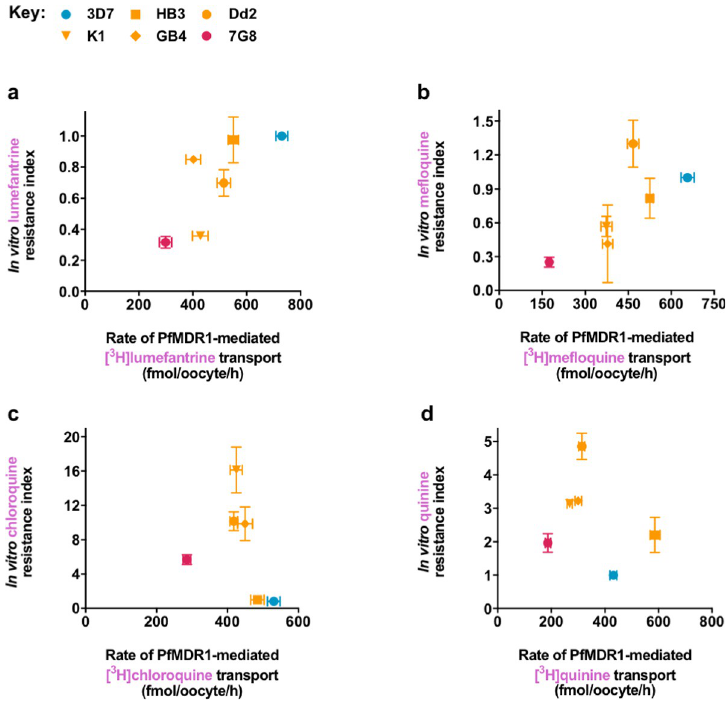
Fig 5. Correlations between rates of drug transport via PfMDR1 in Xenopus oocytes and in vitro parasite drug resistance indices. The rates of PfMDR1-mediated transport of lumefantrine, mefloquine, chloroquine, and quinine (Figs 2 and 4, and S1 Data) were plotted against the in vitro resistance index for the relevant drug and parasite strain (S3 Table). Where not shown, error bars fall within the symbols. (a) A positive correlation was observed between the rate of lumefantrine transport via PfMDR1 and the in vitro lumefantrine response (Pearson correlation coefficient = 0.76, r 2 = 0.58, P = 0.078). (b) A positive correlation was observed between the rate of mefloquine transport via PfMDR1 and the in vitro mefloquine response (Pearson correlation coefficient = 0.75, r 2 = 0.56, P = 0.008). The data point for Dd2 is an outlier and its removal significantly improved the correlation (Pearson correlation coefficient = 0.97, r 2 = 0.94, P = 0.006). Dd2 parasites typically harbor 2 to 4 copies of PfMDR1 and have been reported to express greater levels of PfMDR1 than the other parasite strains included in the analysis [85,87]. Given that pfmdr1 amplification has been associated with mefloquine resistance [30–32,88,89], it is possible that the overexpression of PfMDR1 in Dd2 parasites imparts a higher level of resistance to this strain (see S3 Text for an extended analysis). (c) An inverse correlation was observed between the rate of chloroquine transport via PfMDR1 and the in vitro chloroquine response. The removal of the 7G8 data point (see S3 Text for an extended analysis) resulted in a stronger correlation between the rate of chloroquine transport via PfMDR1 and the parasite’s chloroquine response in vitro (Pearson correlation coefficient = − 0.86, r 2 = 0.74, P = 0.054). (d) There was no correlation between the rate of quinine transport via PfMDR1 and the in vitro quinine response (see S4 Text for an extended analysis). The data for the in vitro resistance indices are the mean of n = 2 to 18 published studies, and the data for the PfMDR1-mediated drug transport rates are the mean of n = 4 independent experiments. The error is the SEM except for the in vitro resistance indices that were calculated from 2 studies, in which case the error is the range/2. The data underlying this figure is supplied in S3 Data. PfMDR1, Plasmodium falciparum multidrug resistance protein